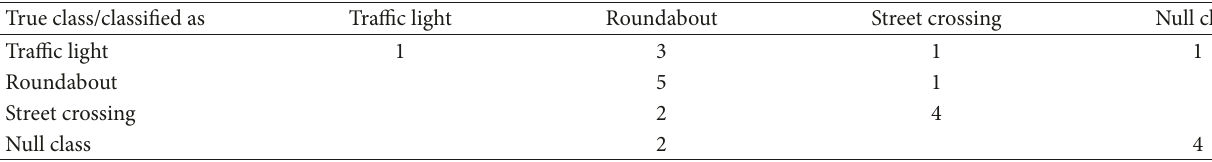
Table 8: Confusion matrix using the 𝑘 -NN ( 𝑘 = 1 )